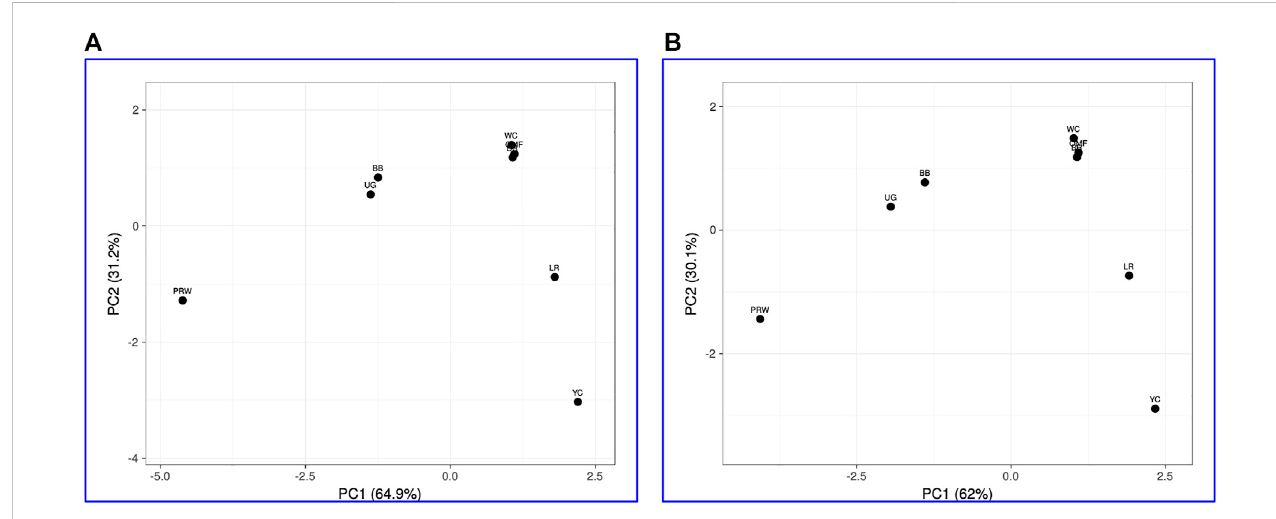
FIGURE 2 PCA plots generated using the ClustVis tool (Metsalu and Vilo, 2015) and the Type IIIa (A) and IIIb (B) datasets as inferred for the eight studied breeds and seventestedmyogenesisassociatedgenesexpressedinthebreastmuscles. X and Y -axesshowprincipalcomponent1(PC1)andprincipalcomponent2(PC2) that explain 64.9% and 31.2% (A) , and 62.0% and 30.1% (B) of the total variance, respectively. N = 8 data points